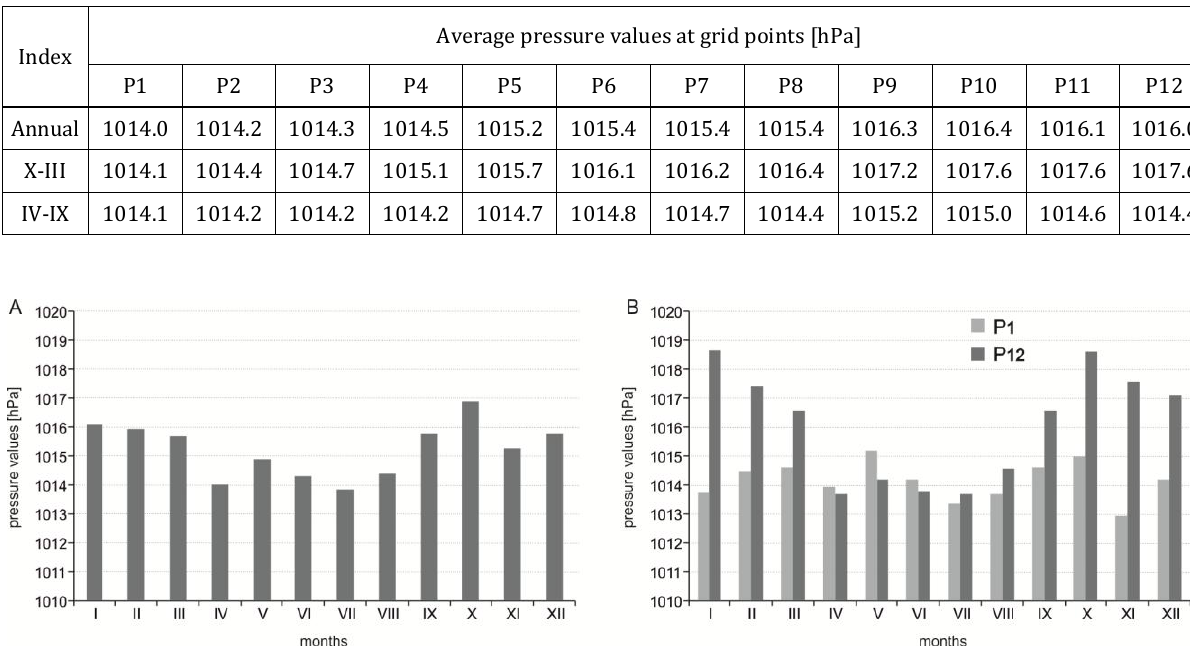
Table 1. Average air pressure values at particular grid points in the period 1951-2015